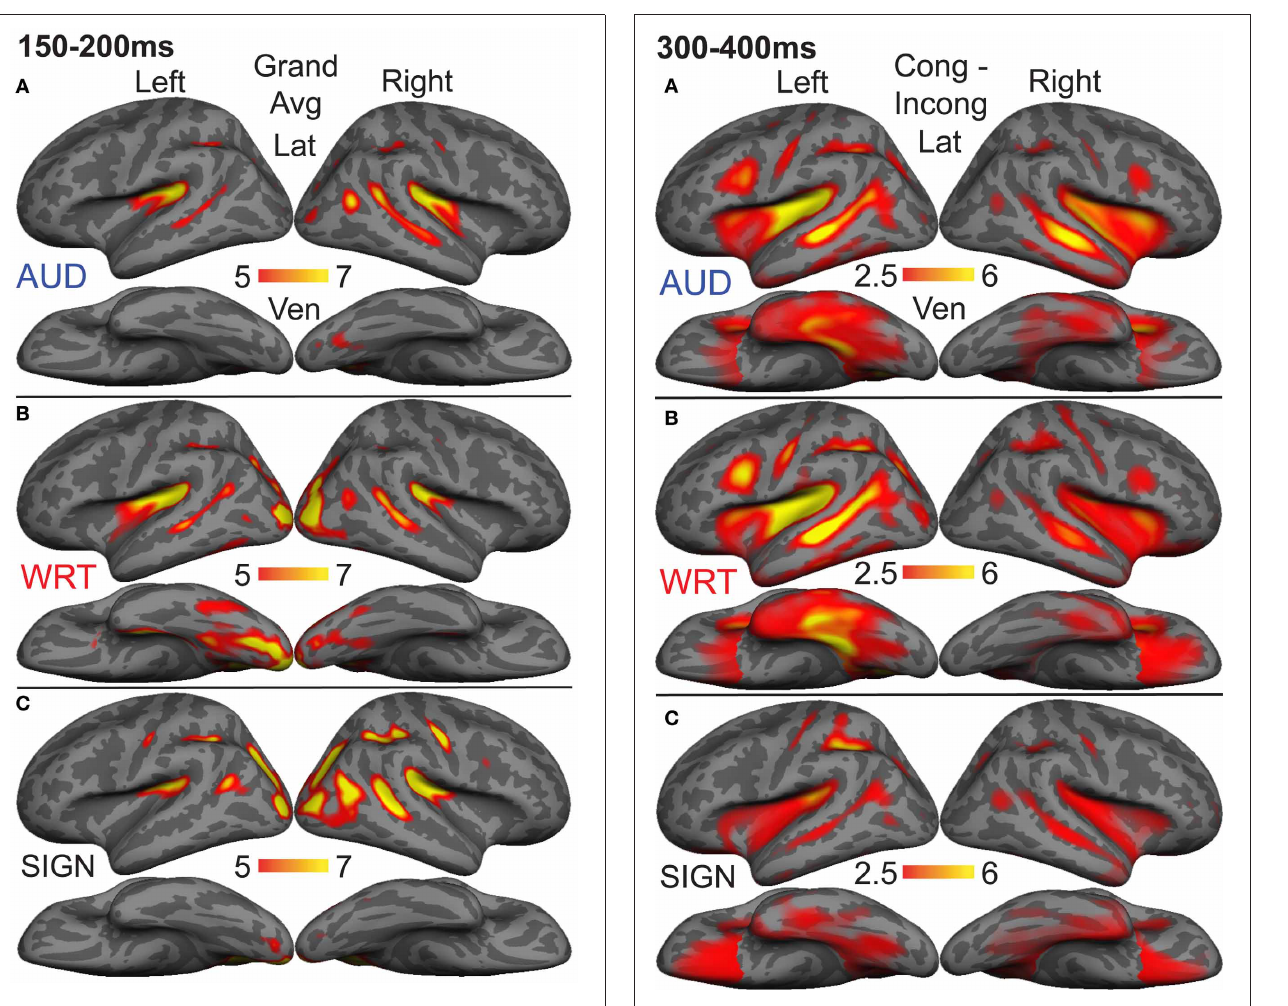
FIGURE 6 | Congruent-Incongruent subtraction dSPMs during the late lexico-semantic time window from 300 to 400ms. (A–C) All three conditions show similar patterns of activity in predominantly left fronto-temporal regions, including PT, STS, inferior frontal, and anteroventral temporal. (C) Signed words (“SIGN”) show overall smaller subtraction effects. F -values on the color bar represent signal-to-noise